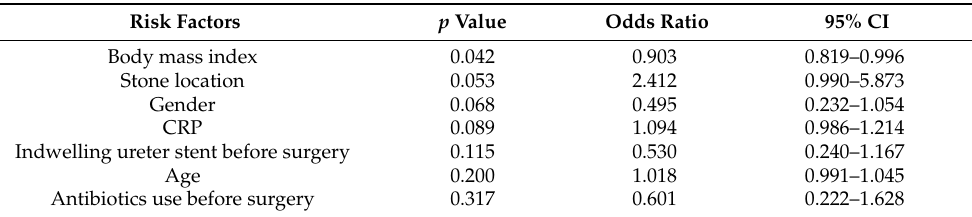
Table 2. Multivariate logistic regression test according to postoperative fever after ureteroscopic